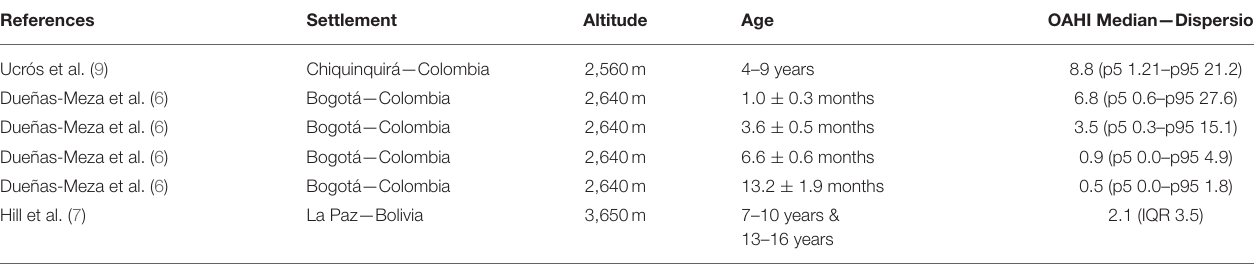
TABLE 3 | Obstructive apnea/hypopnea index (OAHI) according to altitude and age.